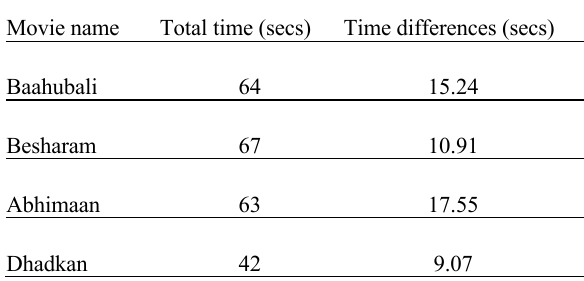
Table 5: Differences in time spent in AOI_Video (without SLS minus with